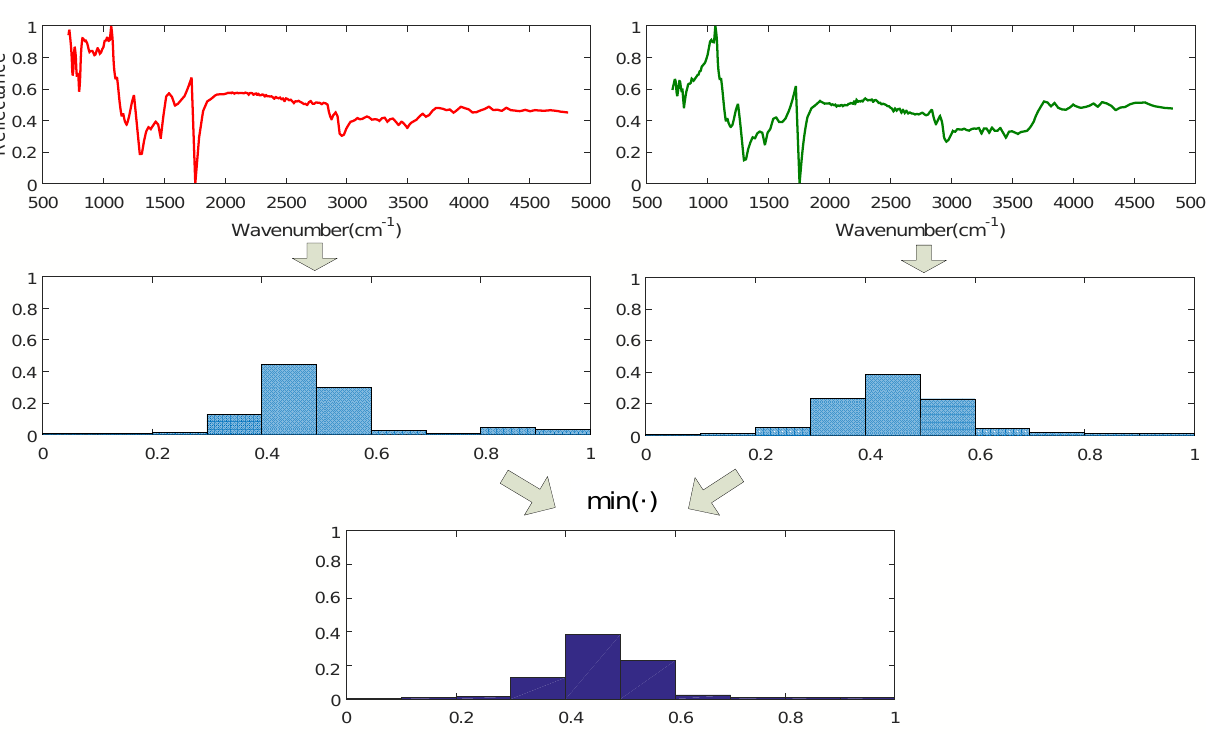
Figure 1. The spatial pyramid at Level 0 ( l = 0 ). The first row: Spectrum A (left), Spectrum B (right). The second row: the histogram of Spec. A (left), the histogram of Spec. B (right). The third row: the histogram intersection kernel referred to in Equation